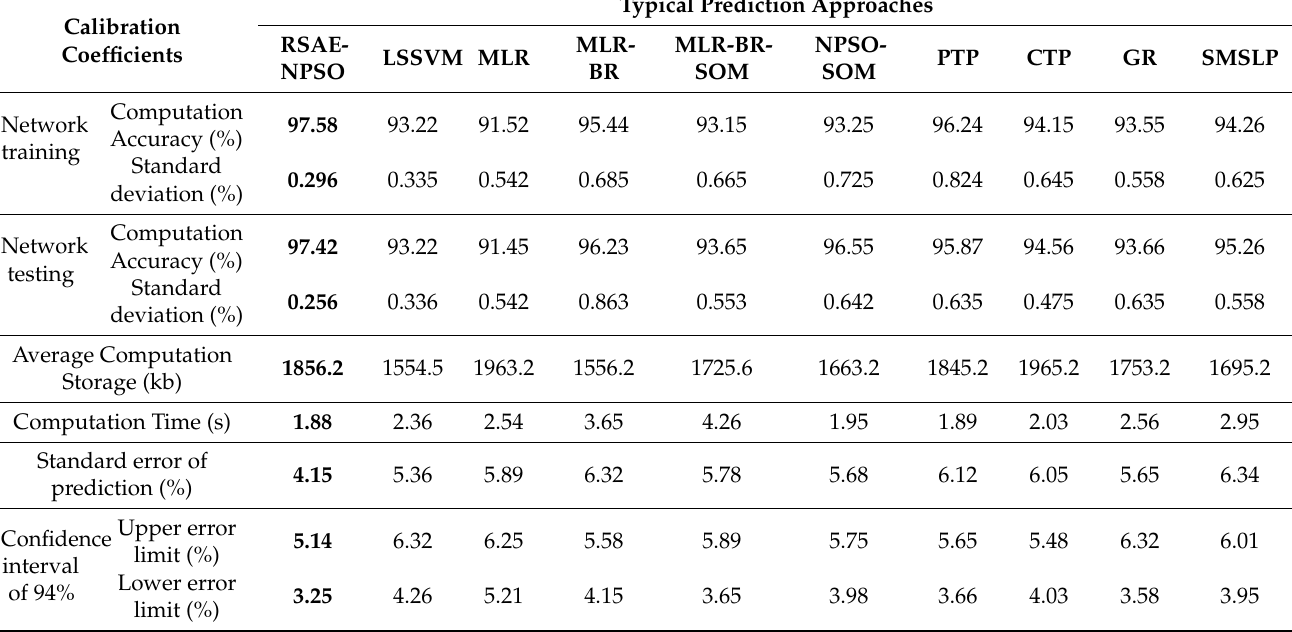
Table 11. Performance comparison of SDIQ index prediction results using RSAE-NPSO and other typical